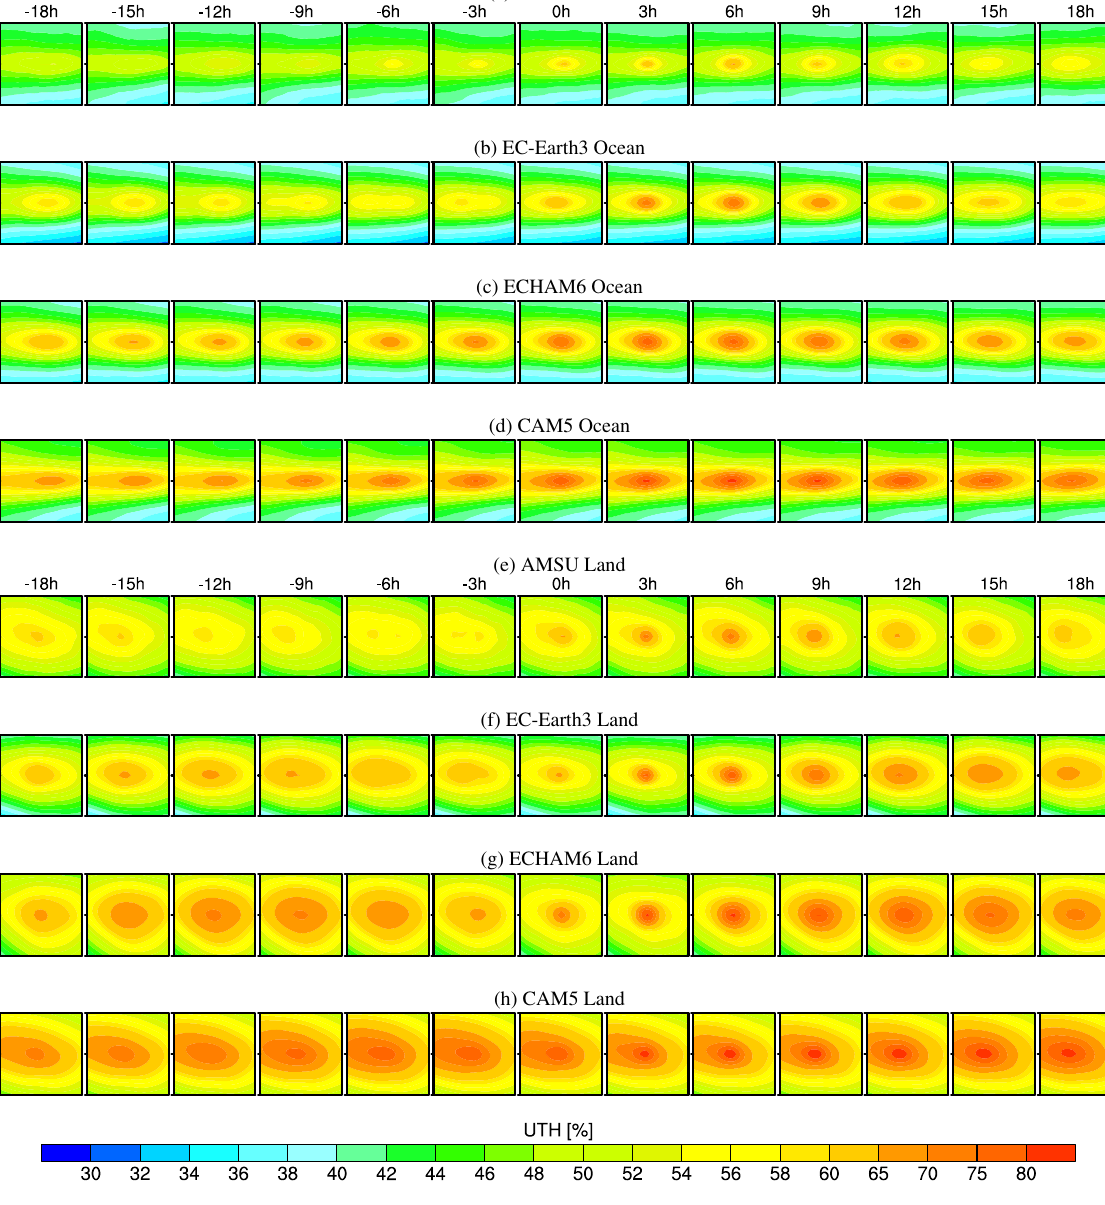
Figure 5. Composite of upper-tropospheric humidity (UTH) for ocean-based (a–d) and land-based (e–h) systems for Advanced Microwave Fig. 5. Composite of upper-tropospheric humidity (UTH) for ocean-based ((a)-(d)) and land-based ((e)-(h)) systems for Advanced Microwave Sounding Unit (AMSU) followed by the models. The spatio-temporal coverage is ± 18 hours at every 3-hour interval and ± 10 ◦ longitude Sounding Unit (AMSU) followed by the models. The spatio-temporal coverage of ± 18h at every 3h interval and ± 10 ◦ longitude and latitude and latitude taken from the centre point and graduated every ± 1 ◦ . is taken from the centre point and graduated every ± 1 ◦ counted as CF. This must be taken into consideration when Also, close to the domain centre, the spatial mean CF can interpreting the results. exceed 70 % . For the 2C-ICE-derived ocean-based systems, the mean The models’ ocean-based systems show mean CFs across CF of the domain is on the order of 22 % . There is an in- the domain that are slightly larger than 2C-ICE, ∼ 28 % for creased CF at the domain centre from about − 9 h to 9 h. EC-Earth3, ∼ 29 % for ECHAM6, and ∼ 31 % for CAM5.